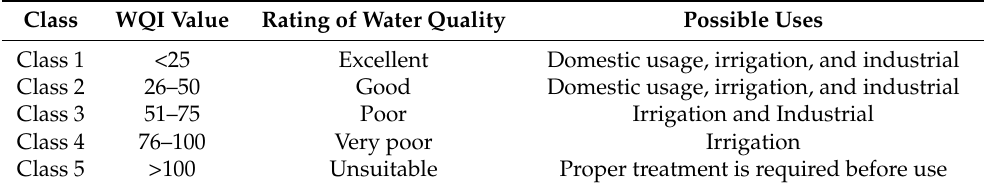
Table 3. Estimations of water quality index method for suitability of water uses (classification for decreasing scale